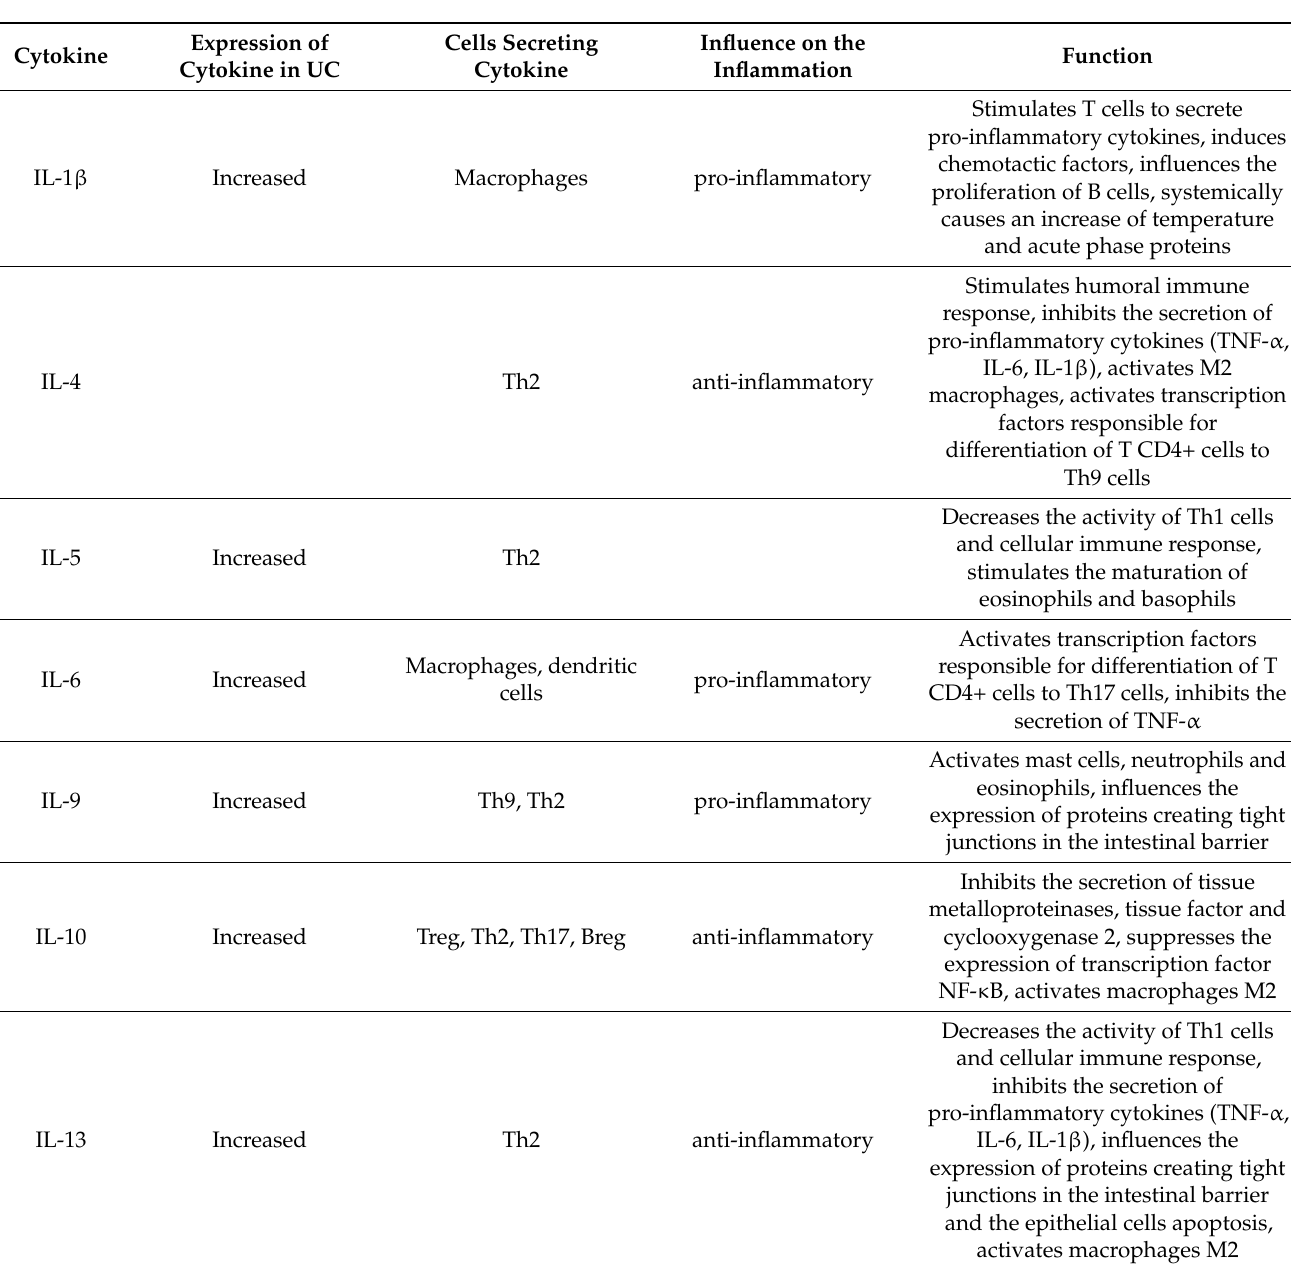
Table 1. The influence of cytokines taking part in the UC pathogenesis on the development of the immune response